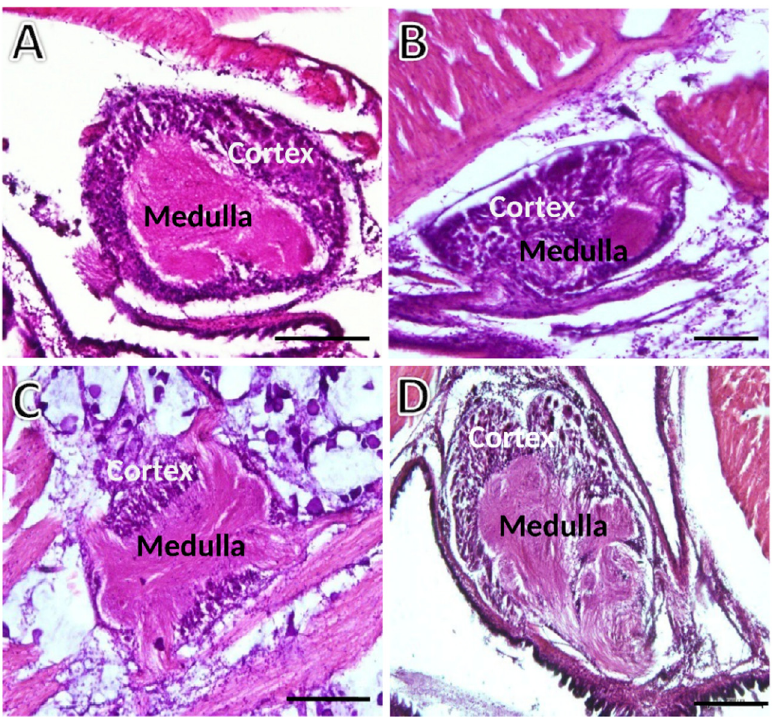
Figure 2. Transversely sectioned ganglia of S. plana picked randomly for illustration purposes. ( A ) Left cerebral ganglion. ( B ) Right cerebral ganglion. ( C ) Pedal ganglion. ( D ) Visceral ganglion. The outer basophilic cellular cortex contrasts with the inner medulla. Six animals per sex condition were used. H&E staining. Scale bar = 200 µm.